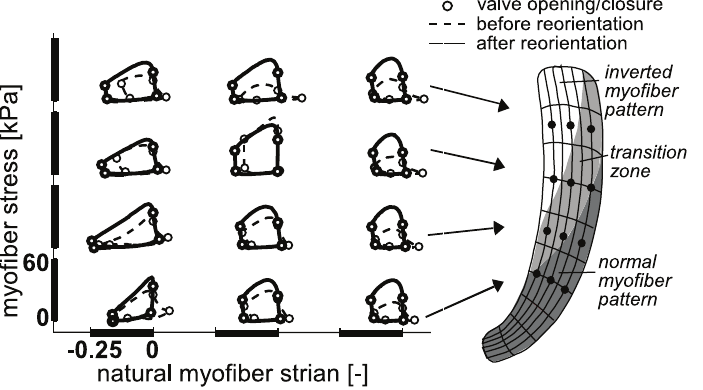
Figure 6. Change in local mechanics as a consequence of myofiber reorientation in SIT simulation MID . Myofiber Cauchy stress-natural strain loops are analyzed in the nodes indicated in the LV mesh (right) before ( 2 2 ) and after ( 2 ) reorientation. The location of the transition zone before reorientation is also indicated in the LV mesh.